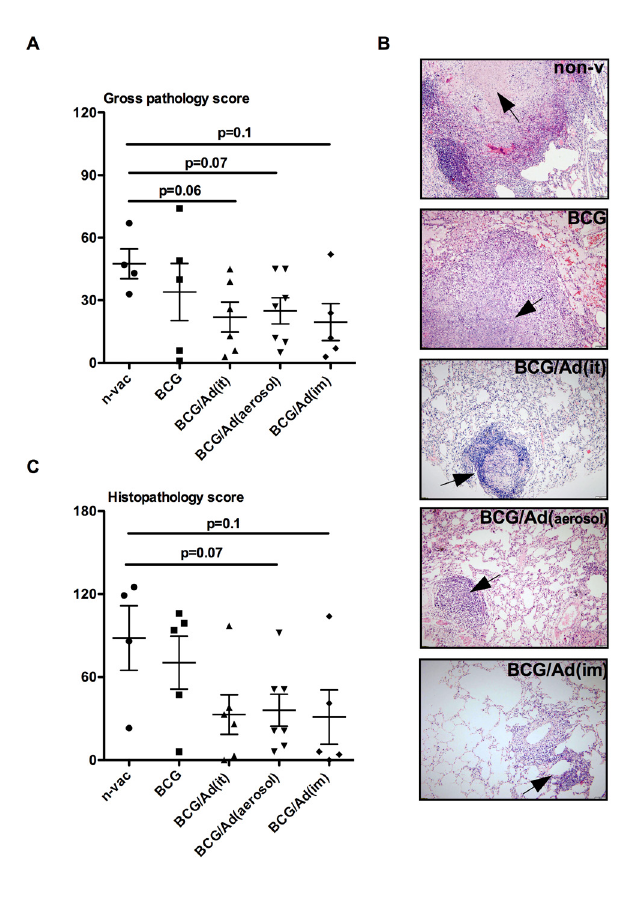
Fig 4. Evaluation of gross pathology and histopathology in M.tb-infected lungs. Individual dots represent scores for animals in each group with mean ± standard error for gross pathology ( A ). ( B ) Representative histomicrographs (x40) of lungs of animals in each group. Arrow points to granuloma with the central caseous necrosis in the lung of non-vaccinated animal (non-v), non-necrotic granuloma in the lung of BCG vaccinated animal (BCG), scattered small size granulomas lacking necrosis in the of lung of AdHu5Ag85A boosted animals (BCG/Ad(it), BCG(aerosol) and BCG(im)). ( C ) Individual dots represent scores for animals in each group with mean ± standard error for histopathology. Mann-Whitney rank test is used to compare differences relative to na ï ve